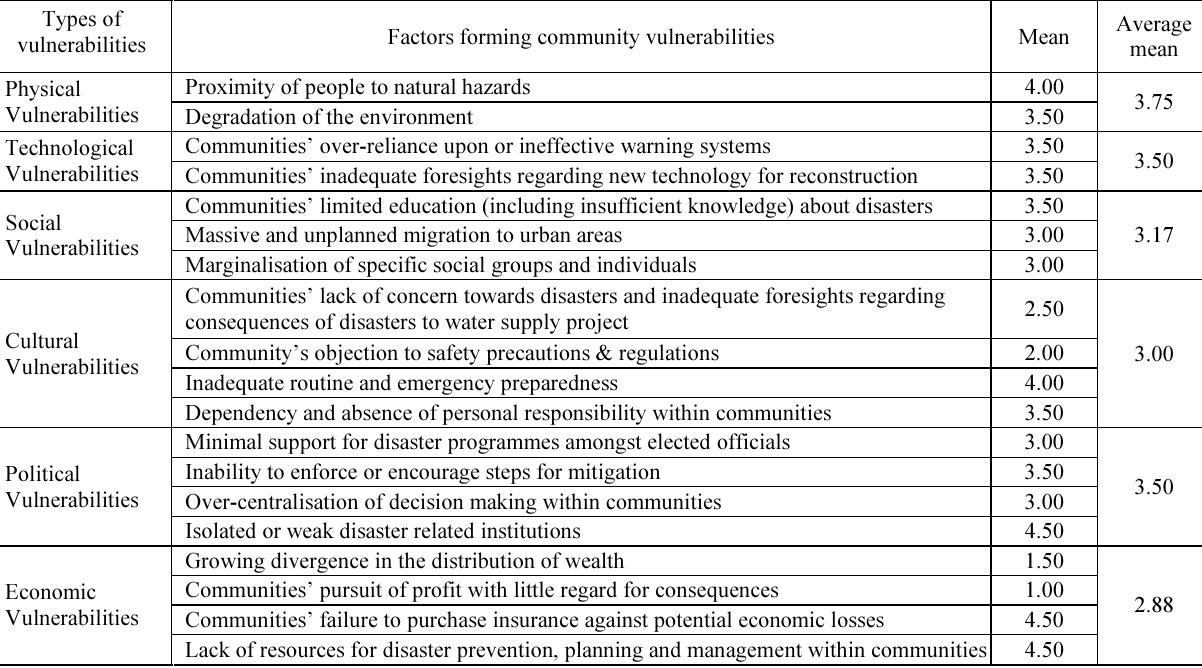
Table 2. Vulnerabilities of communities that benefited from water supply reconstruction project Types